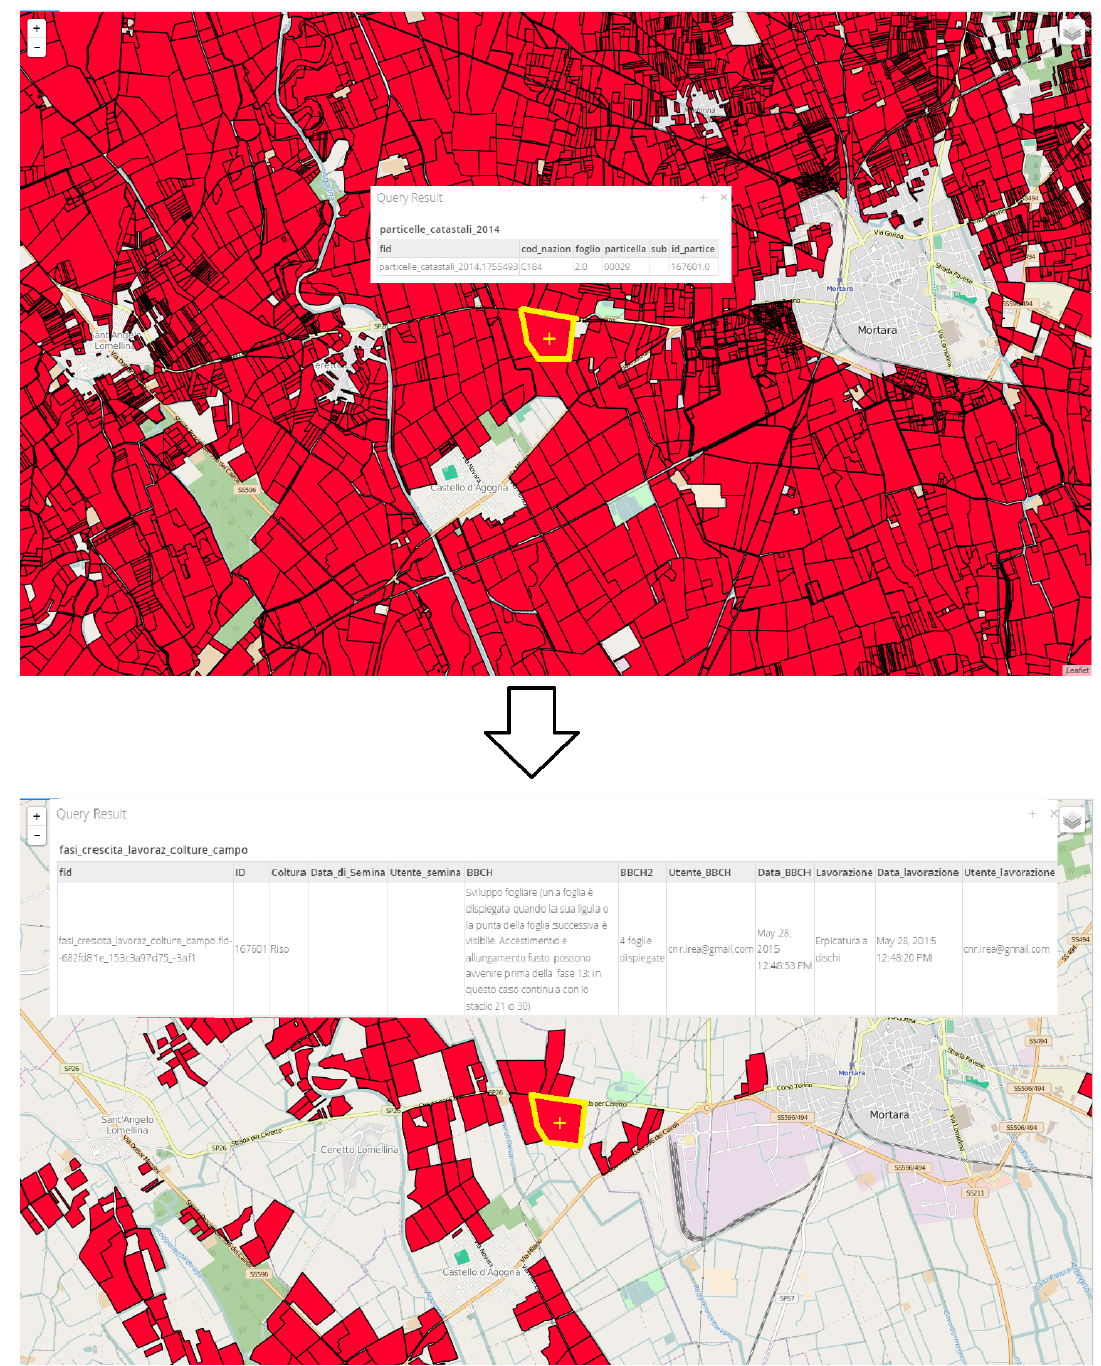
Figure 8. GD set of agricultural parcels from map of cadastral parcels and subset with extended data collected by field operators and verified by researchers and/or regional operator published as WMS layer and WFS features (source: own processing).